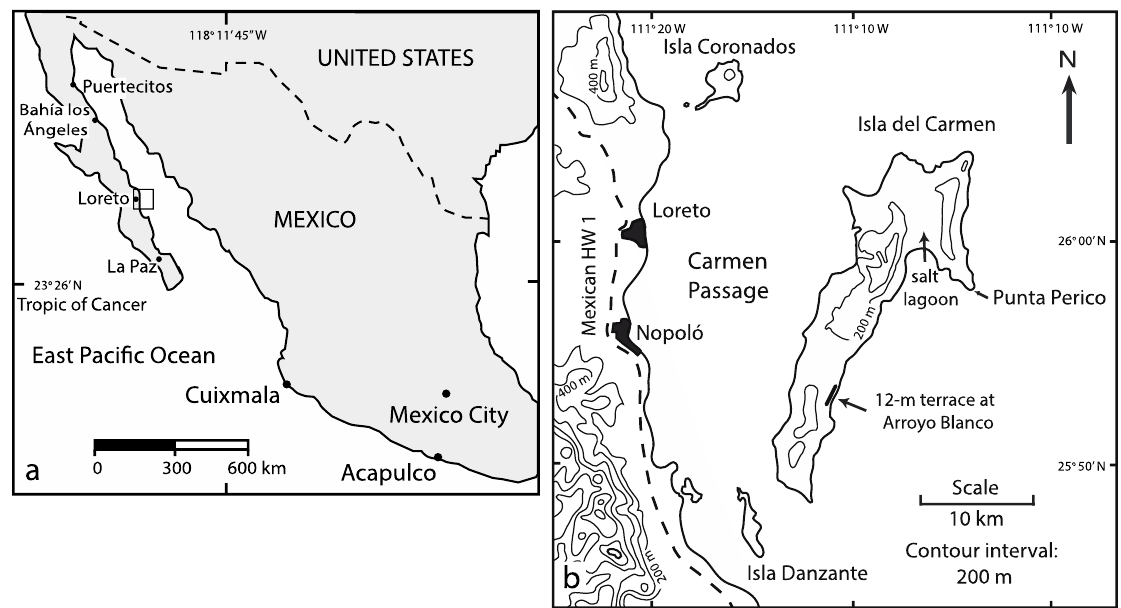
Figure 1. Map showing Mexico’s Baja California peninsula and adjacent Gulf of California: ( a ) Mexico with key cities indicated and inset box to show map enlargement of the Loreto area; ( b ) Isla del Carmen near Loreto on the peninsular mainland with the location of the 12 m limestone terrace marked on the island’s eastern shore.